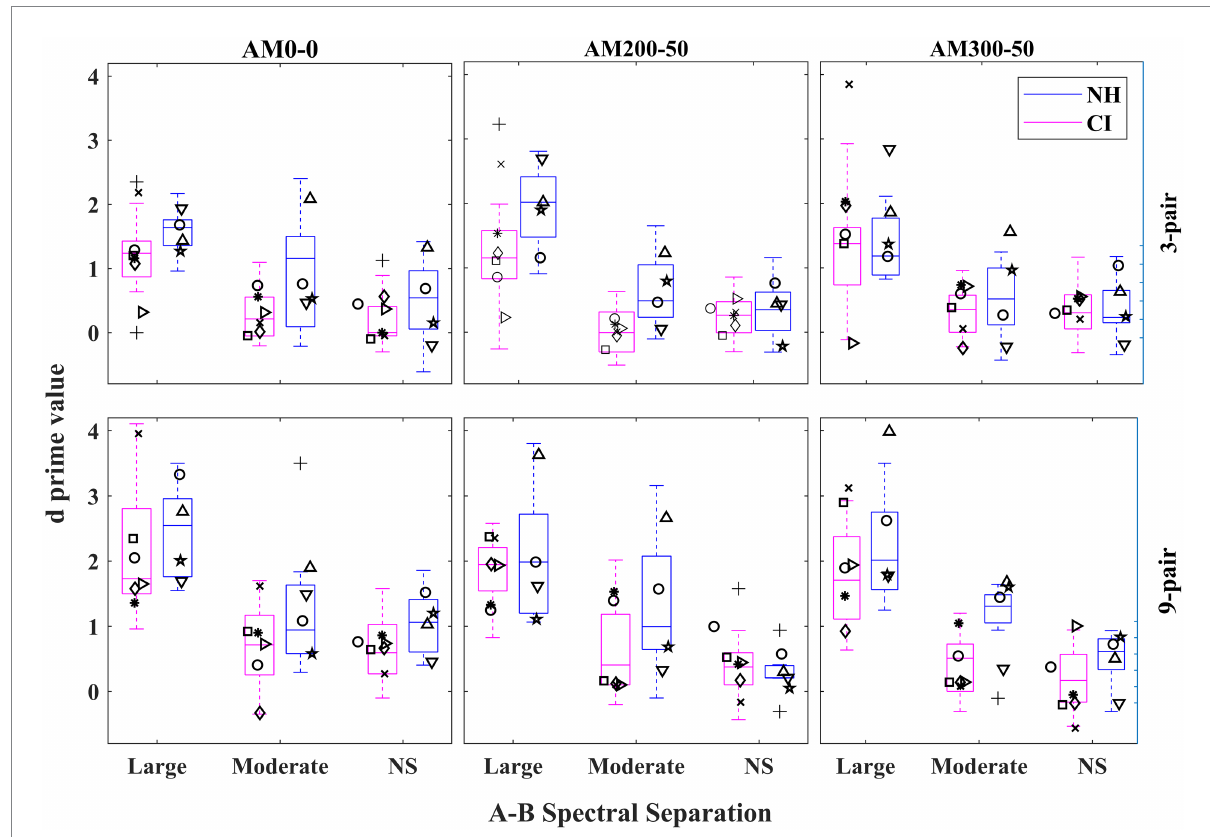
FIGURE 3 Boxplots illustrating d ¢ values for each listener group in different experimental conditions. The boxes show the 25–75th percentile, the error bars show the 5th and 95th percentile, the plus signs show outliers, the solid horizontal line shows median performance. The rows show different sequence durations while the columns show the condition of AM-rate separation. NS = No-Separation. Each participant’s d ¢ mean of the two repetitions in each condition is also depicted with a unique symbol for the same listener across all